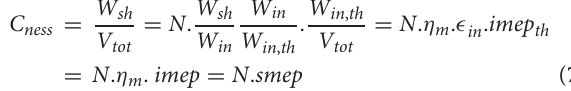
Frontiers in Energy Research |